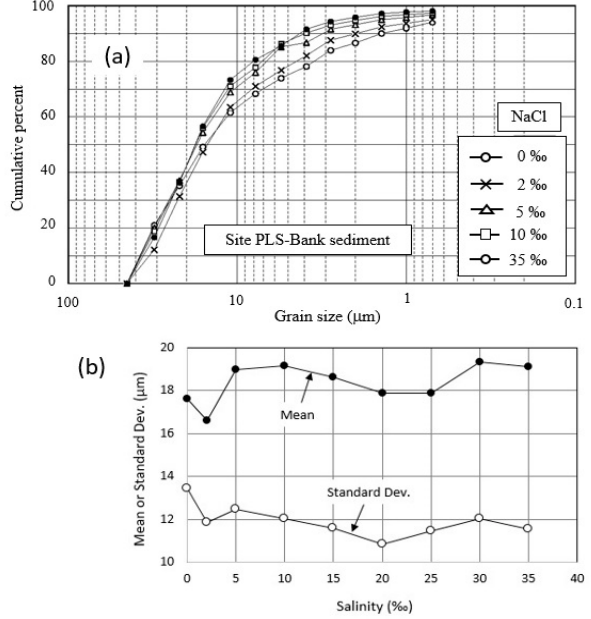
Figure 8. Changes in ( a ) cumulative grain size distributions and ( b ) correspondent mean size and standard deviation of the Yukon River bank sediment at grain size d ≤ 44 μ m by increasing the salinity from 0 to 35 ‰.